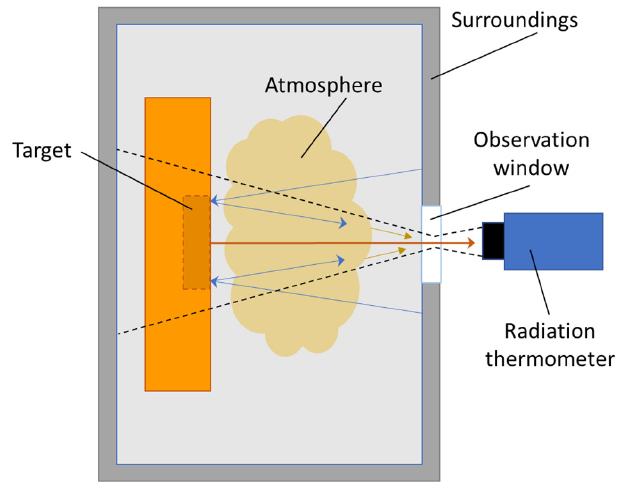
Figure 4. The figure illustrates the different components of the radiation received by the thermometer. Ambient temperature compensation is important when the target does not fill the thermometer’s field of v completely and especially if the target is cooler than the surroundings.